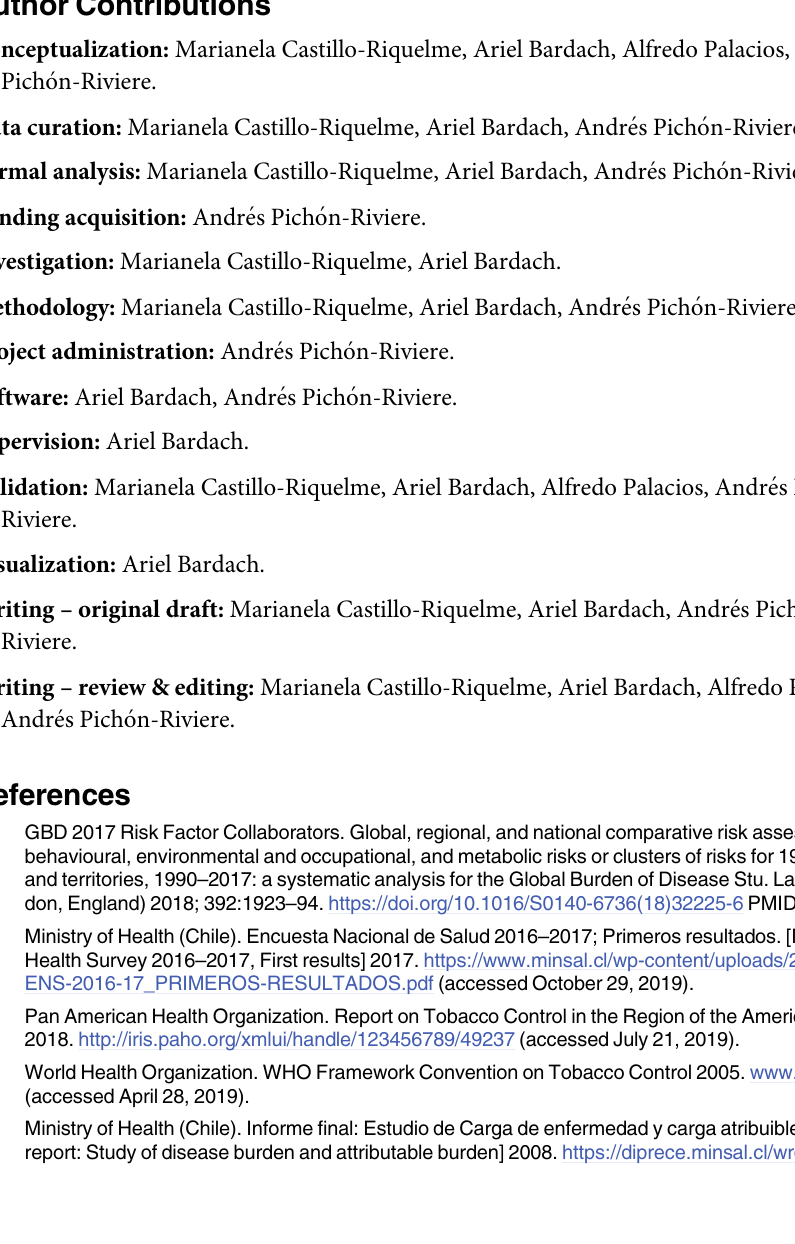
S2 Table. Relative risks of mortality for smokers and ex-smokers for each tobacco-related condition, by sex (in reference to